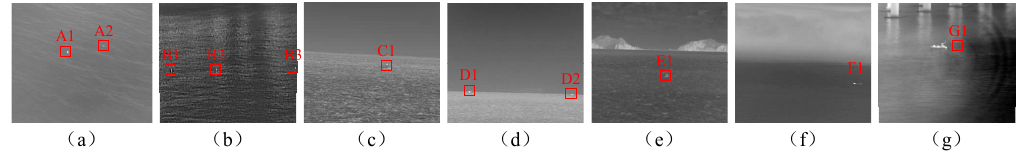
Figure 12. Experimental image:( a ) two targets with different contrast on a calm sea; ( b ) three targets with different contrast on the sea with uneven brightness; ( c ) target on the sea with obvious waves; ( d ) two targets on the horizon line; ( e ) island interference in the image; ( f ) fog interference in the image; ( g ) extremely small and dim target